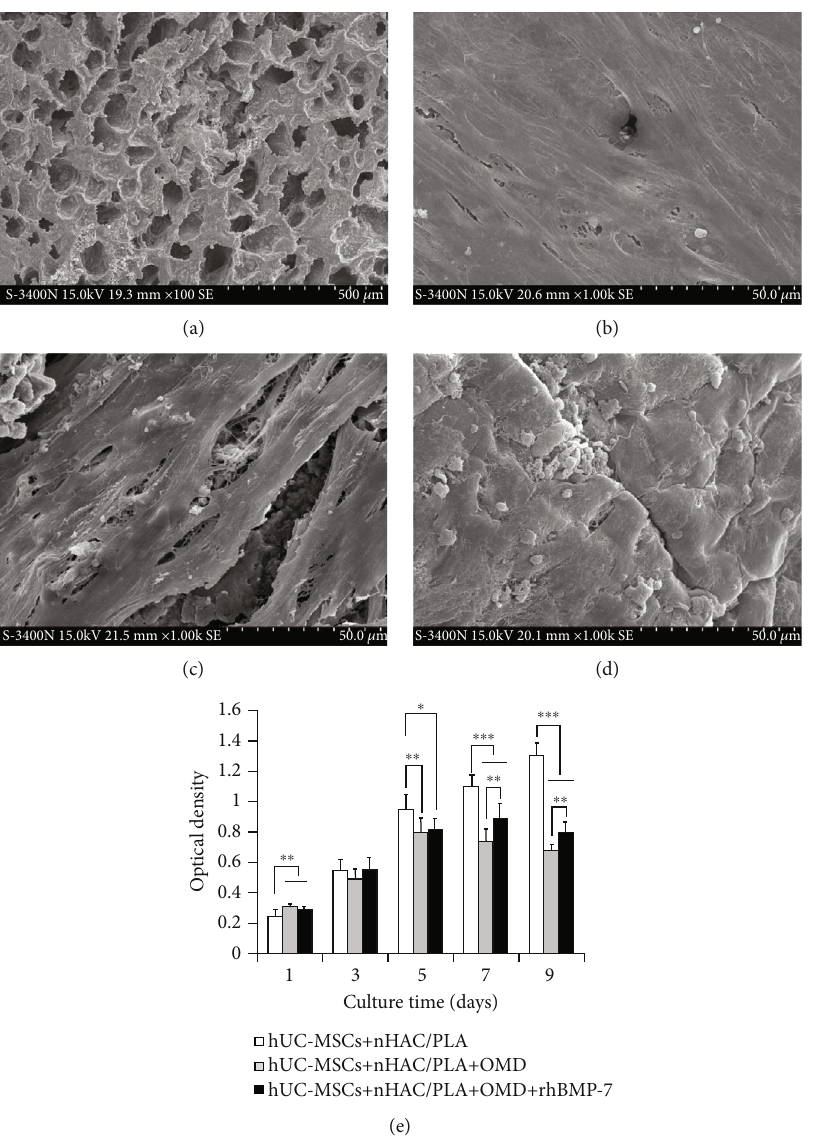
Figure 5: Scanning electron microscopy observation for 7 days and the proliferation ability of hUC-MSCs for 1, 3, 5, 7, and 9 days in the in vitro three-dimensional culture microenvironment. (a) nHAC/PLA ( scale bar = 500 μ m ). (b) hUC-MSCs+nHAC/PLA ( scale bar = 50 μ m ). (c) hUC-MSCs+nHAC/PLA+OMD ( scale bar = 50 μ m ). (d) hUC-MSCs+nHAC/PLA+OMD+rhBMP-7 ( scale bar = 50 μ m ). (e) Proliferation ( mean ± SD , n = 8 ). ∗ P < 0 : 05 , ∗∗ P < 0 : 01 , ∗∗∗ P < 0 : 001